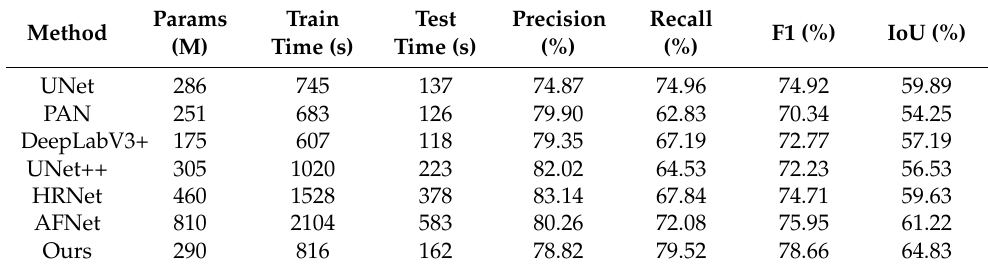
Table 4. Quantitative comparison of our proposed structure and SOTA methods on the LSAG dataset.